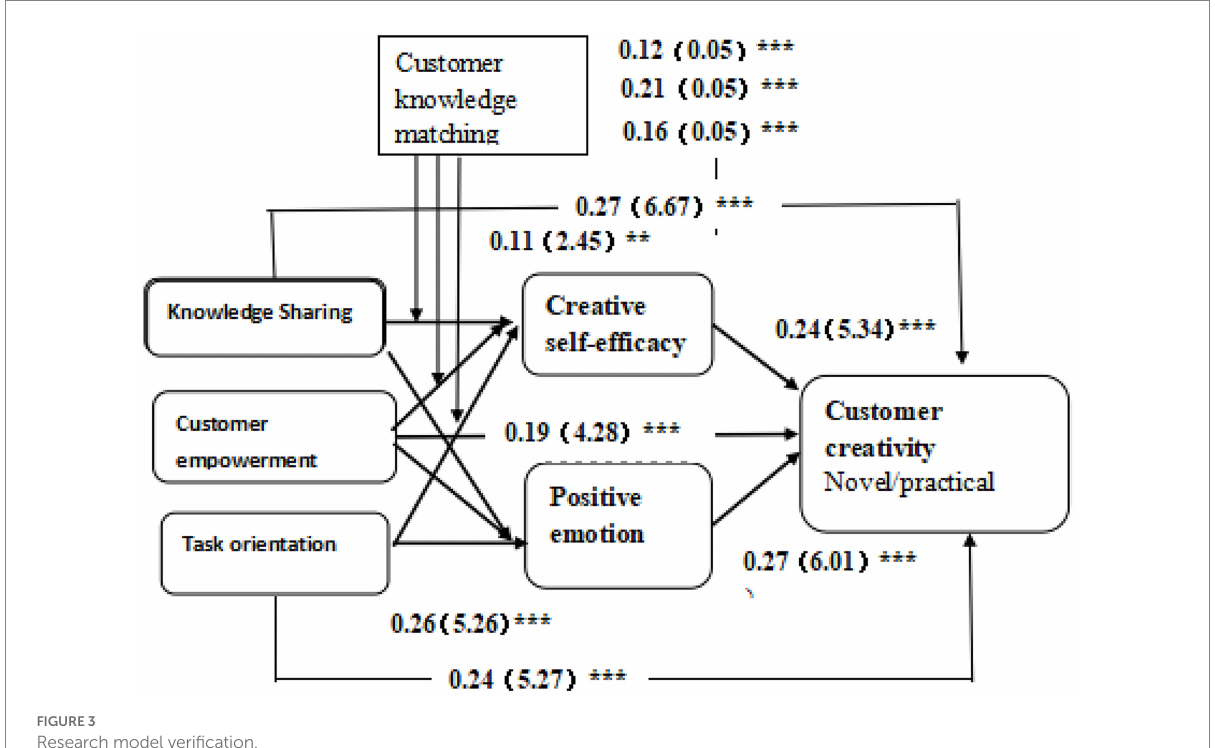
FIGURE 3 Research model